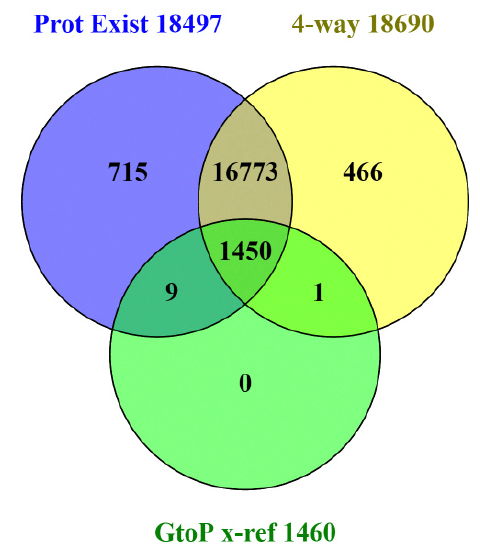
Figure 6. Corroboration of human proteins in Swiss-Prot with ligand interactions in GtoPdb (selected as “Guideto- PHARMACOLOGY” in the Chemistry cross-references). The first of the two intersected lists are labelled as “Prot Exist” with evidence at the transcript and protein levels (i.e. PE1 and PE2 from Figure 4), and the 4-way major source consensus set (i.e. the central panel of Figure